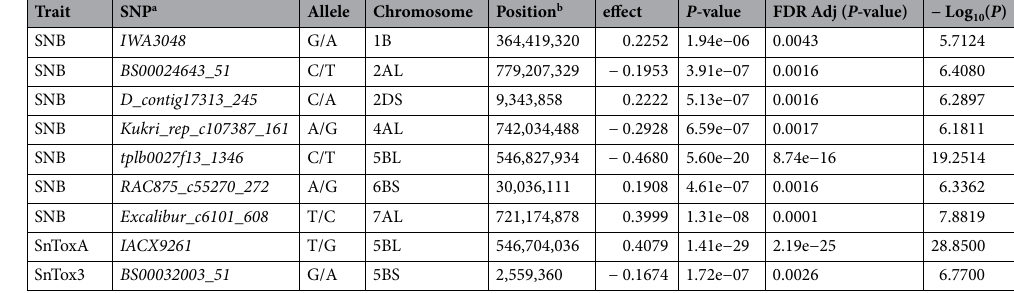
Table 2. Summary of the significant markers associated with SNB resistance and necrotrophic-effector sensitivity. All the markers were declared significant based on Bonferroni corrected significance threshold value of − log 10 P > 5.50. a SNP markers are from Infinium 90K array-based SNPs (Wang et al. 2015). b Physical location is based on IWGSC RefSeq v 1.1